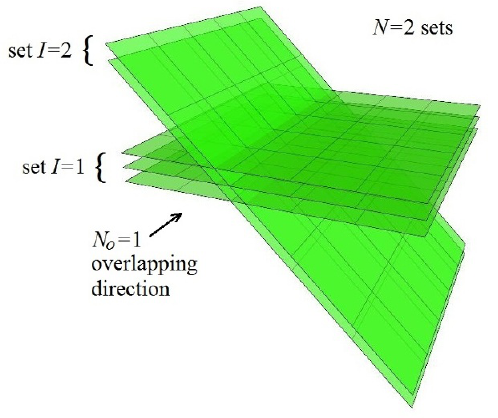
Figure 2 . Each set I = 1 ; 2 is made of parallel D p =O p , and the di(cid:11)erent sets intersect each other. The N = 2 sets have N o = 1 common (internal) direction, where their sources